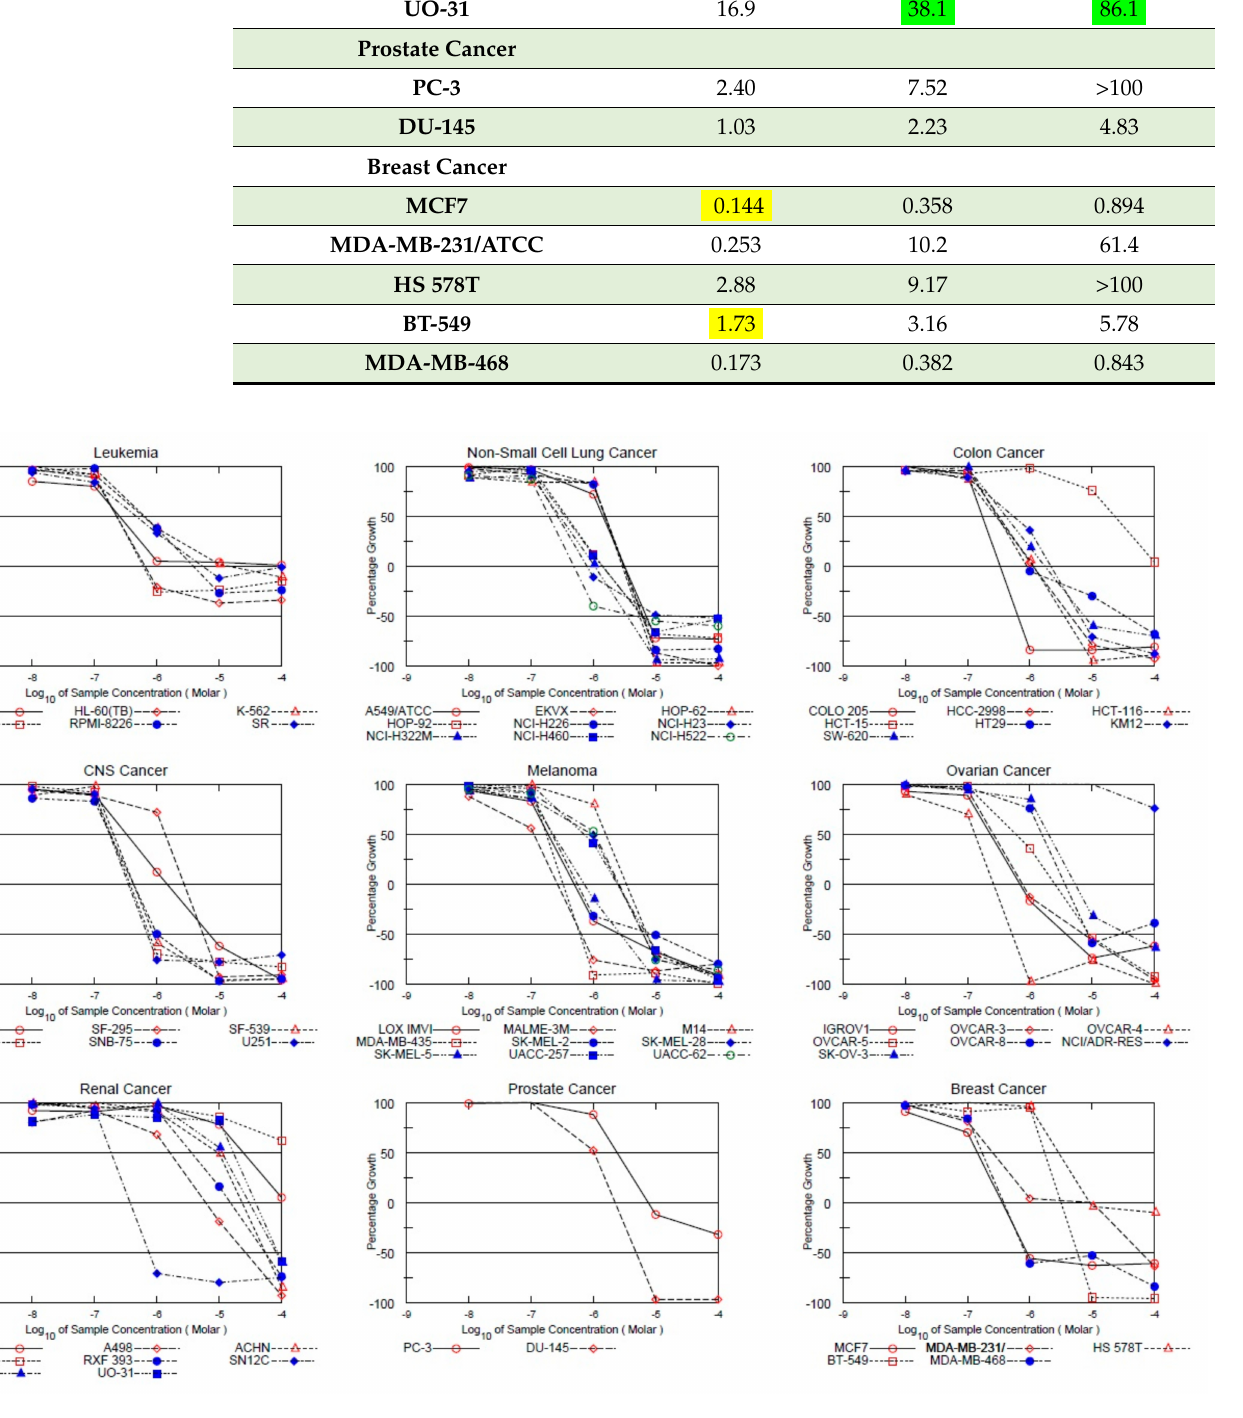
Figure 3. Dose–response curves of the cytotoxic activity of MS47 (NSC778438) against the panel of sixty human cancer cell lines. Value of 100 for the growth percentage indicates the growth of untreated cells, while a growth percentage value of 0 indicates no net growth throughout the period of the experiment, and a growth percentage value of − 100 represents that all of the cells were killed by MS47